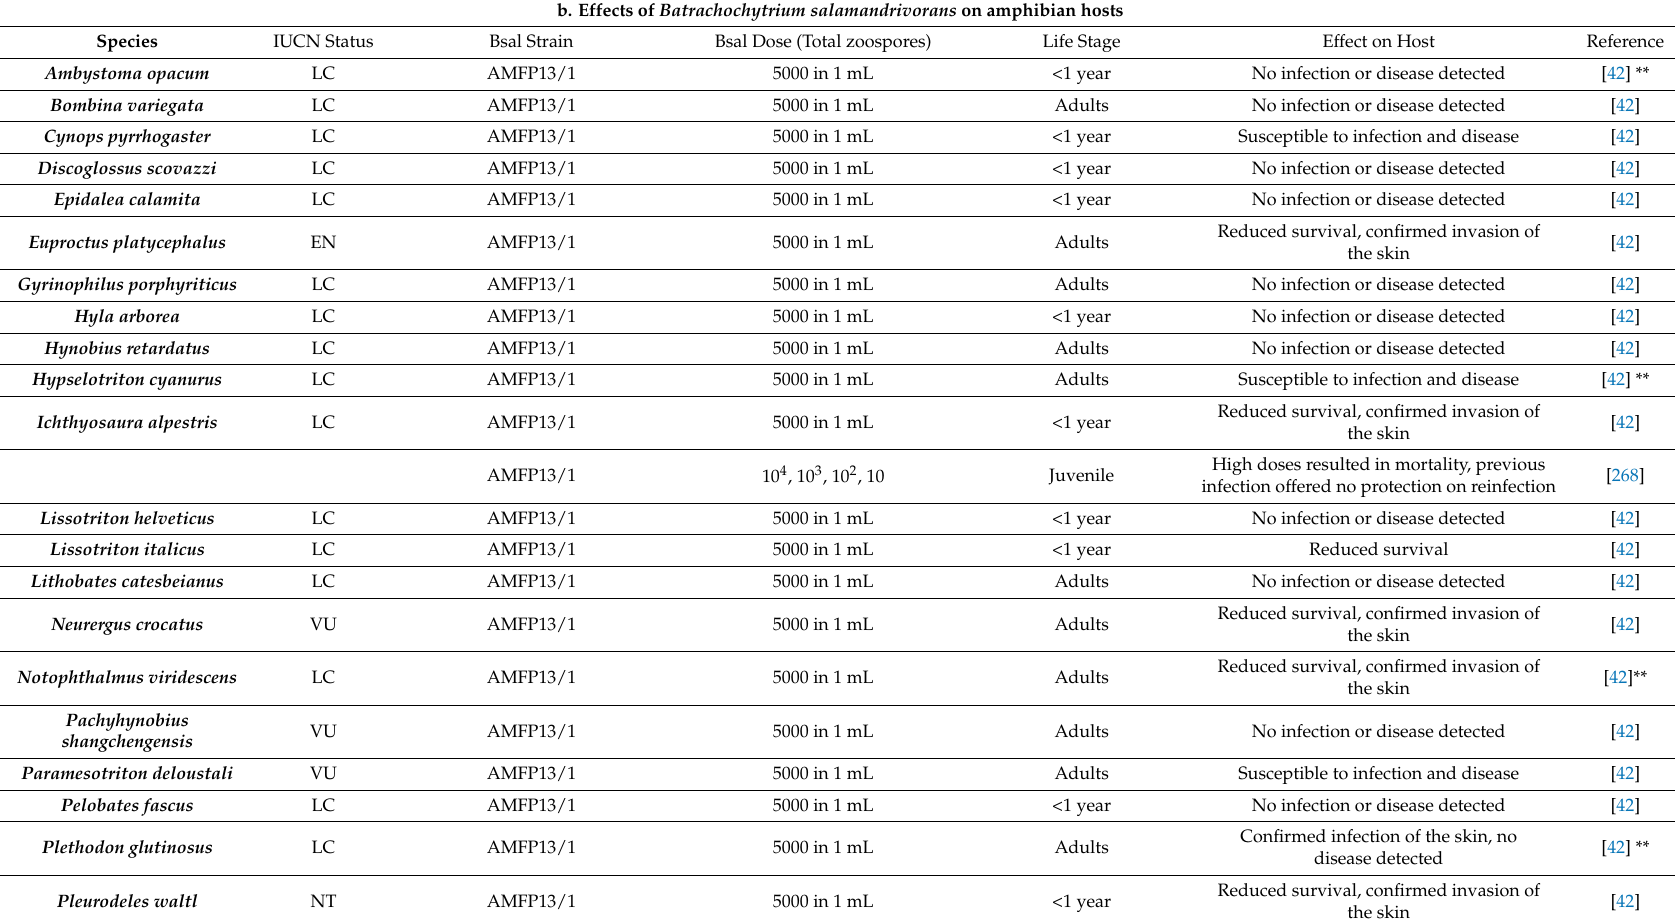
b. Effects of Batrachochytrium salamandrivorans on amphibian